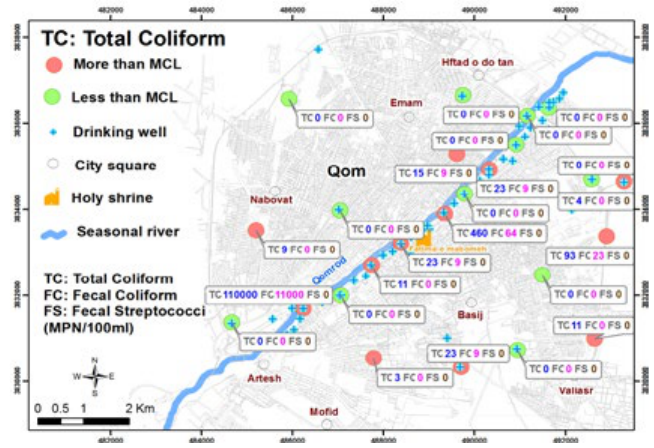
Fig. 7. TC, FC and FS of Groundwater in Qom urban